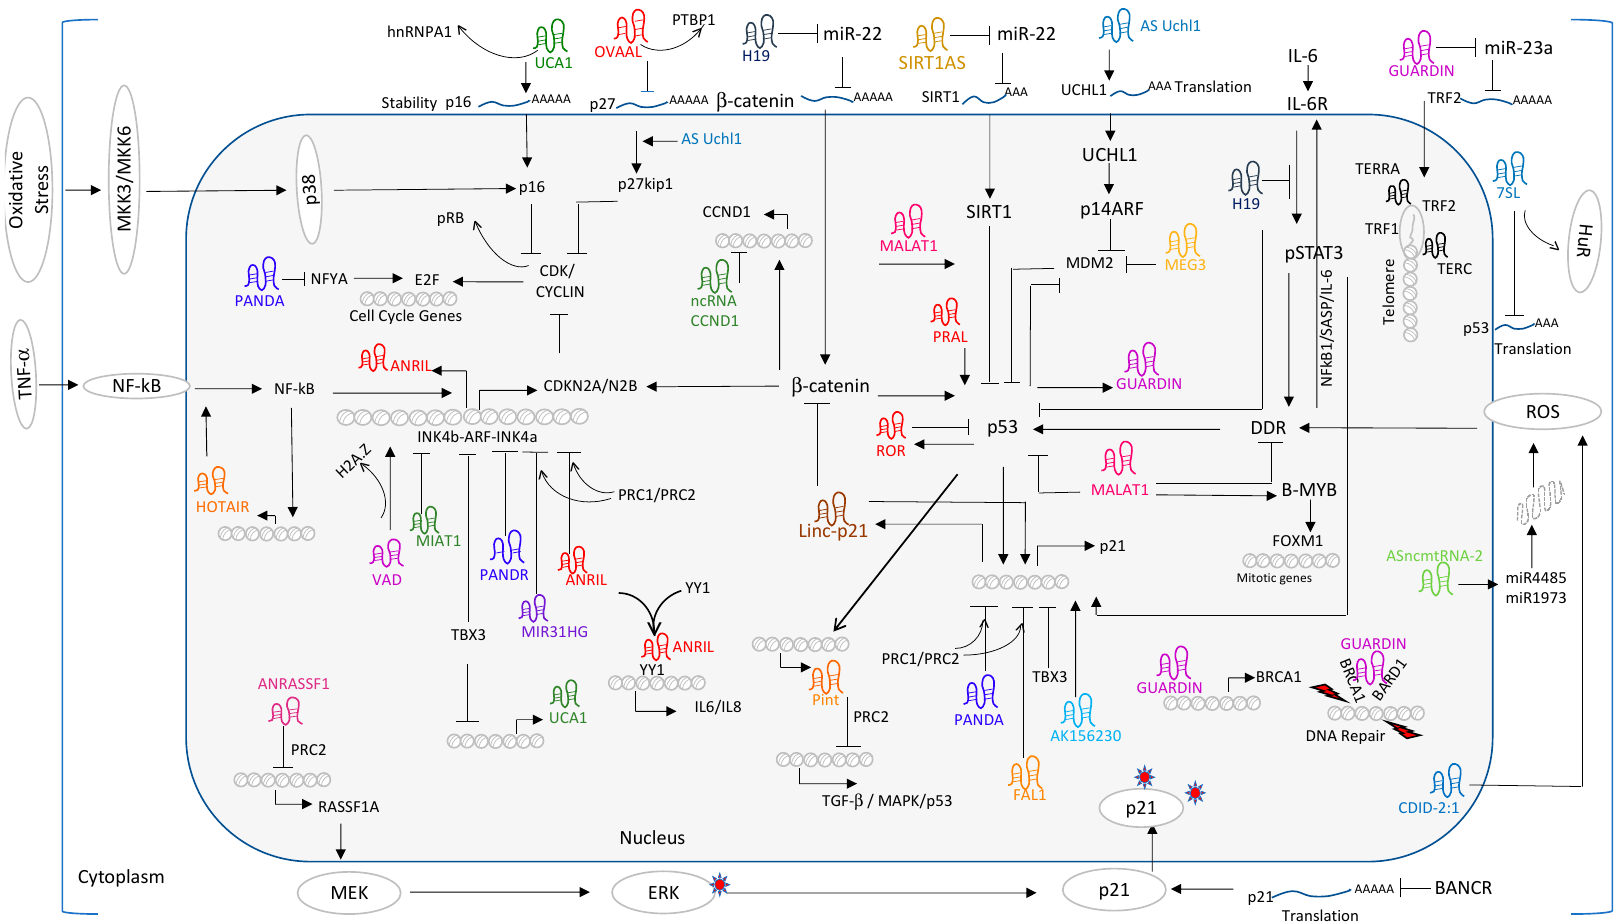
Figure 1. lncRNAs affect senescence pathways. External and internal factors trigger intracellular signaling pathways; these include MAPK, NF-kB, p53/p21, Rb/p16, IL-6/STAT3, b-catenin, and DDR. Activation of these pathways initiates cell cycle inhibition and promotes pro-senescence markers and inflammatory response. lncRNAs function at different stages either by activator or inhibitor of gene regulation